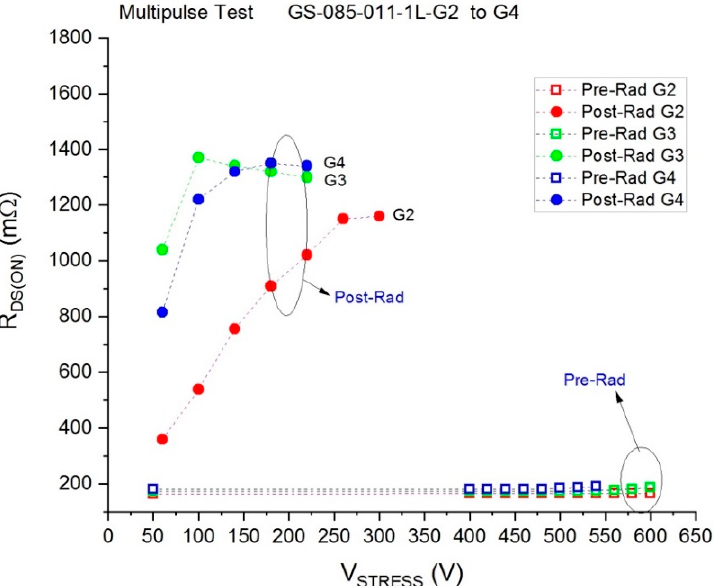
Figure 11. The results of the multi-pulse test for the R ON values of devices G2–G4, which were irradiated at 133 °C.